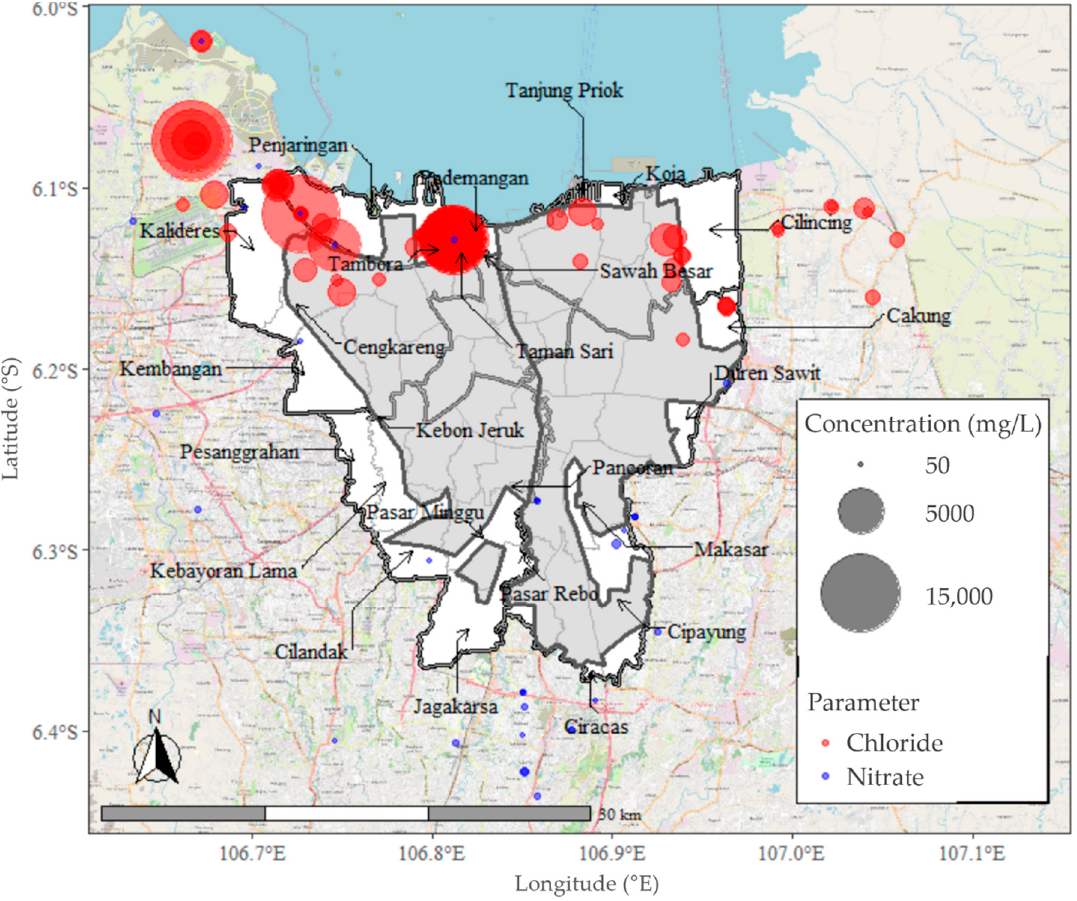
Figure 9. Chloride and nitrate concentrations in groundwater monitoring wells.